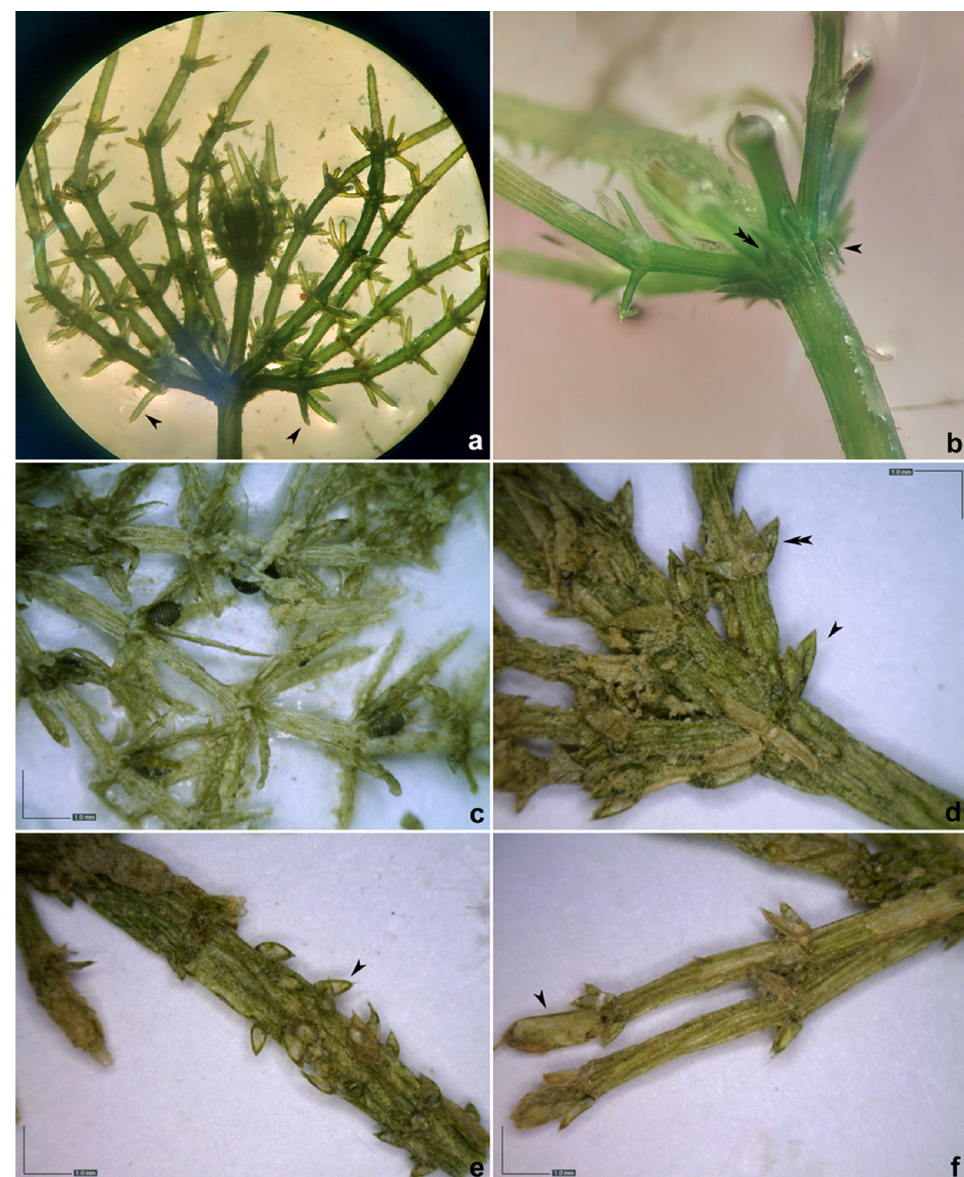
Figure A4. Chara globata ( a – c ), C. tomentosa ( d – f ): ( a )—upper part of plants with typical branchlets completely differentiated with long squarrose verticillate bract cells, Lake Anniversery, ( b )—base of branchlet whorl with elongate acute stipulodes (arrowhead), tylacanthous stem cortex with short spine cells, short extrastipulode is visible in upper row (double arrowhead), Kapchagay Reservoir, ( c )—parts of branchlets with long verticillate bract cells and oogonia with ripe oospores, Lake Mynaral, ( d )—base of branchlet whorl with typical inflated stipulodes (arrowhead), branchlets with typical inflated bract cells (double arrowhead), Lake Mynaral, ( e )—stem with inflated spine cells (arrowhead), ( f )—branchlets with inflated penultimate cell (arrowhead), Lake Mynaral. Scale: 1 mm. Photos a, ( b )—by G. Jumakhanova, ( c – f )—by S.S. Barinova.